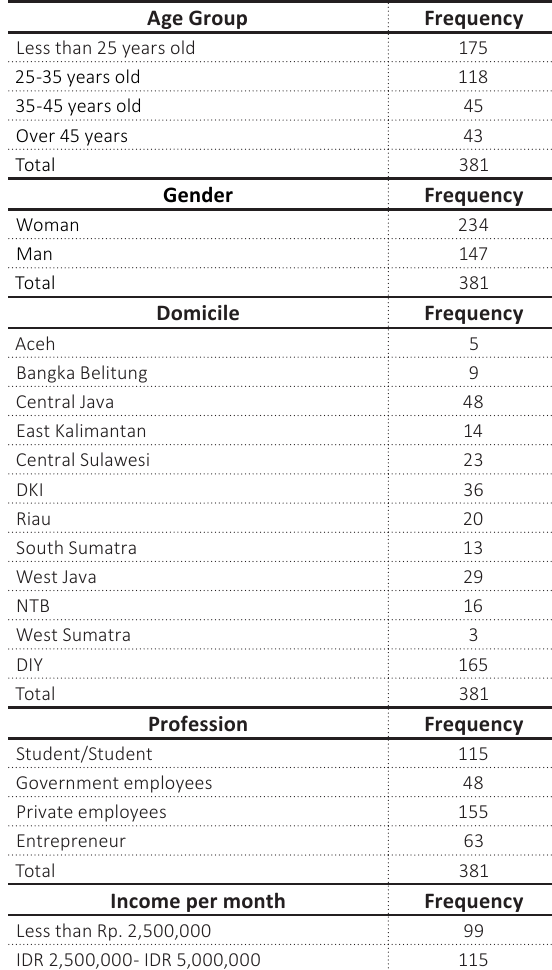
Table 1. Respondents criteria